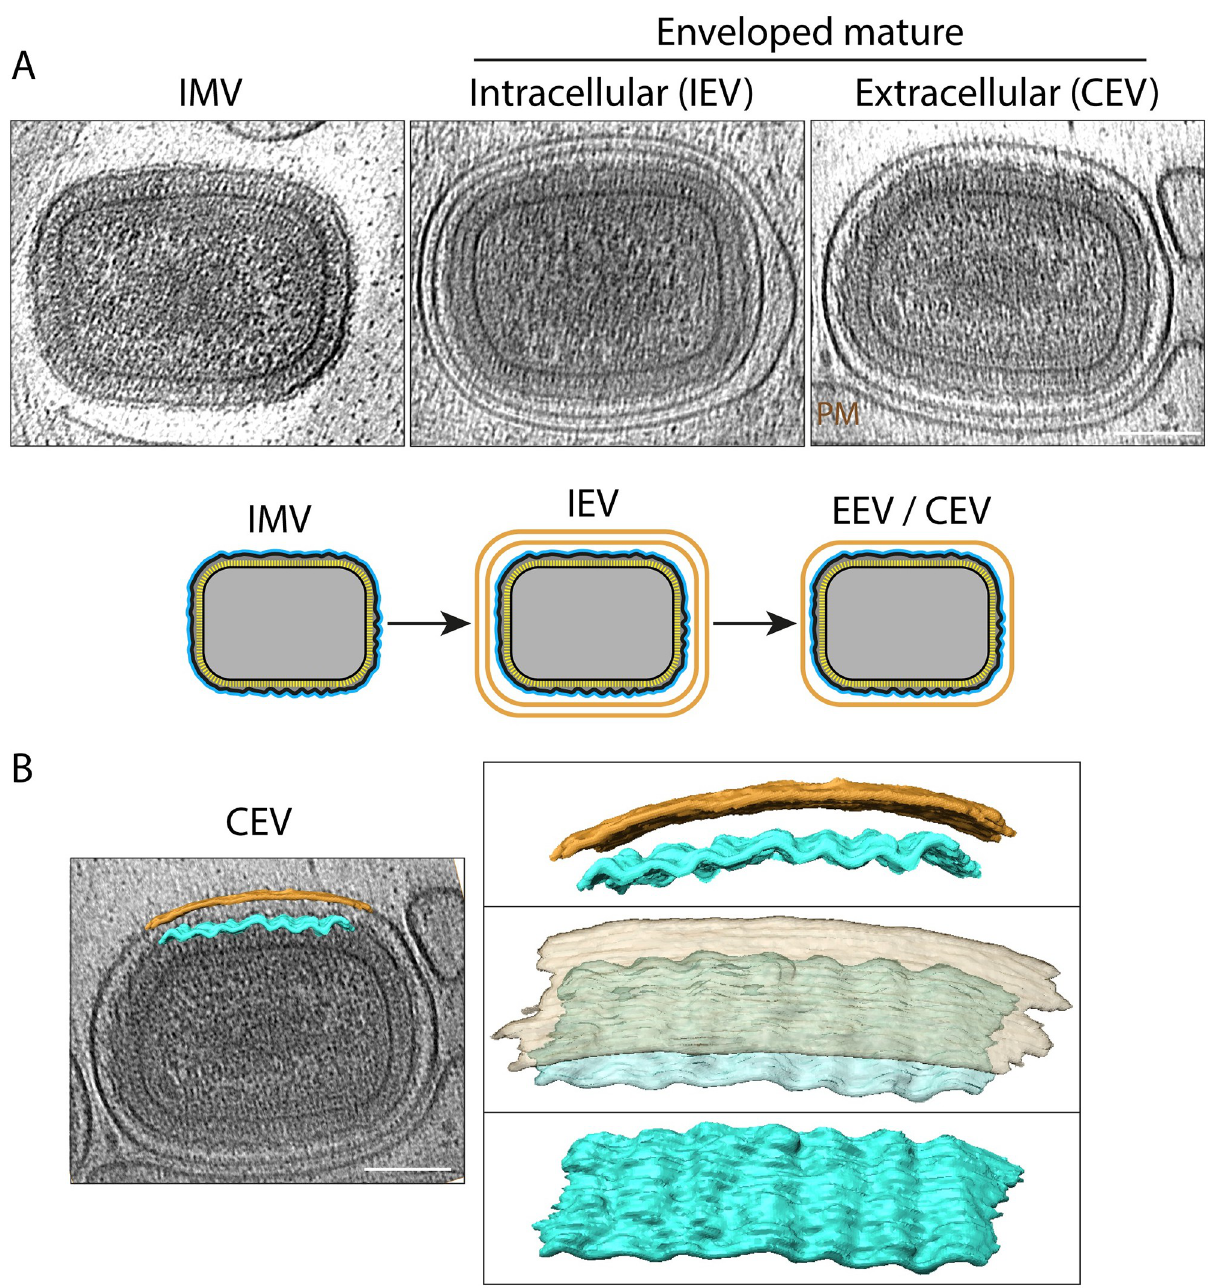
Fig 7. The invariant architecture of the corrugated IMV membrane. ( A ) Central plane of tomograms showing that the additional membranes of IEV and CEV (associated with the PM) do not alter the ultrastructure of the internal IMV. A schematic representation illustrating the number of membranes of IMV, IEV, and EEV/CEV is shown beneath the tomograms. ( B ) Segmented membranes of the CEV shown in (A), highlighting the corrugated character of the inner membrane, which is in contrast to the smooth outer membrane of the CEV. The images on the right show views of the segmented portions of the inner (cyan, 450 × 65 nm) and outer (orange, 520 × 65 nm) membranes. Scale bars = 100 nm. CEV, cell-associated enveloped virus; EEV, extracellular enveloped virion; IEV, intracellular enveloped virion; IMV, intracellular mature virion; PM, plasma membrane.